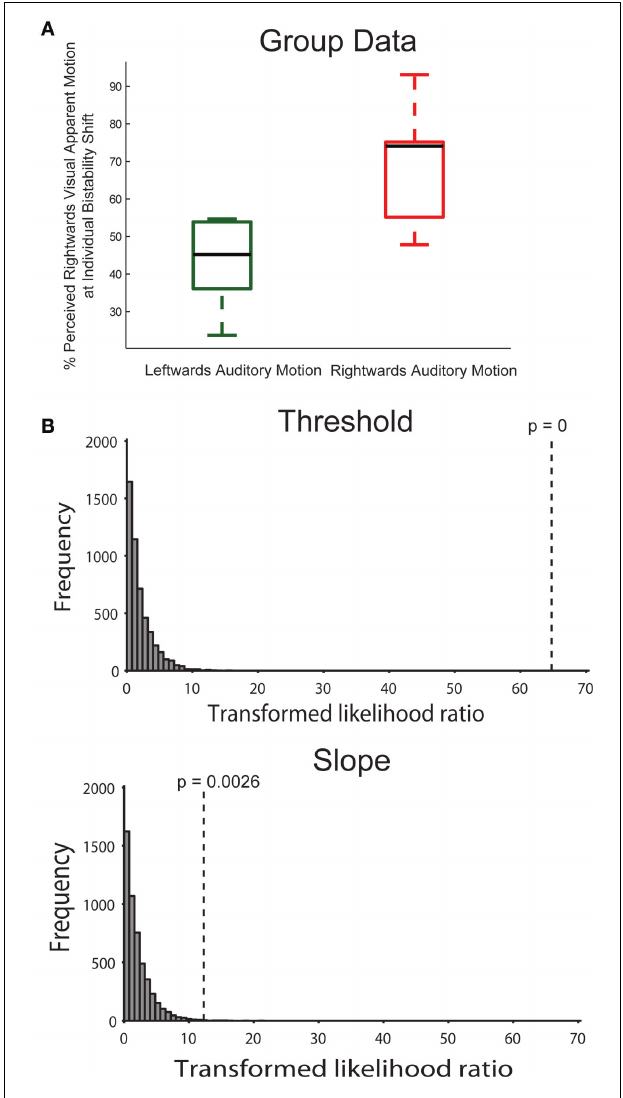
FIGURE 3 | (A) Same as Figure 2A right but showing the results for the control experiment. (B) In the control experiment, the bootstrapping analysis (see Figure 2B ) confirmed the threshold effect. Additionally, this analysis identified a difference in the slope parameter of the psychometric